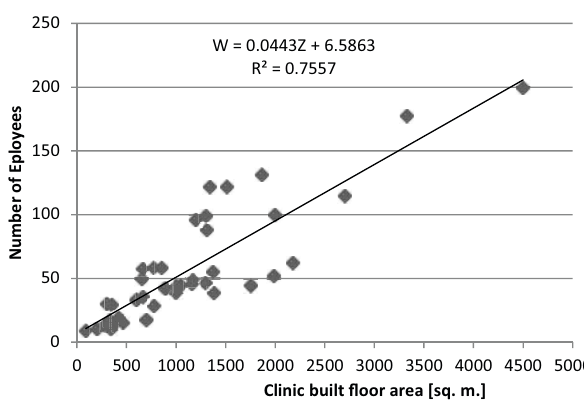
Fig. 6. Number of employees vs. clinic built floor